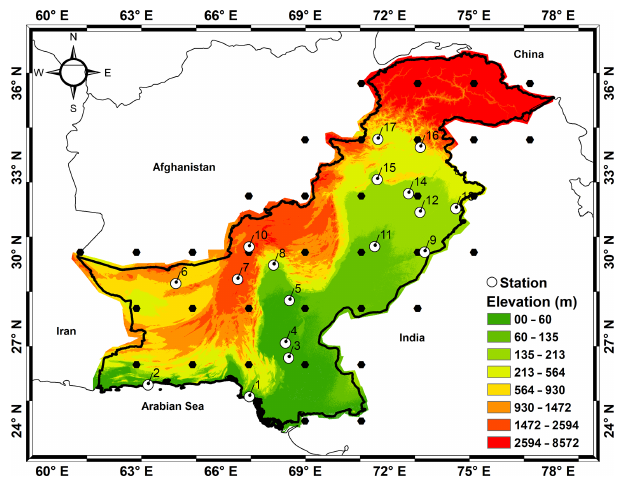
Figure 1. The location of Pakistan in central–south Asia and the GCM grid points over the country along with the locations of pre- cipitation and temperature observation stations. The names of the stations are given in Table 2.